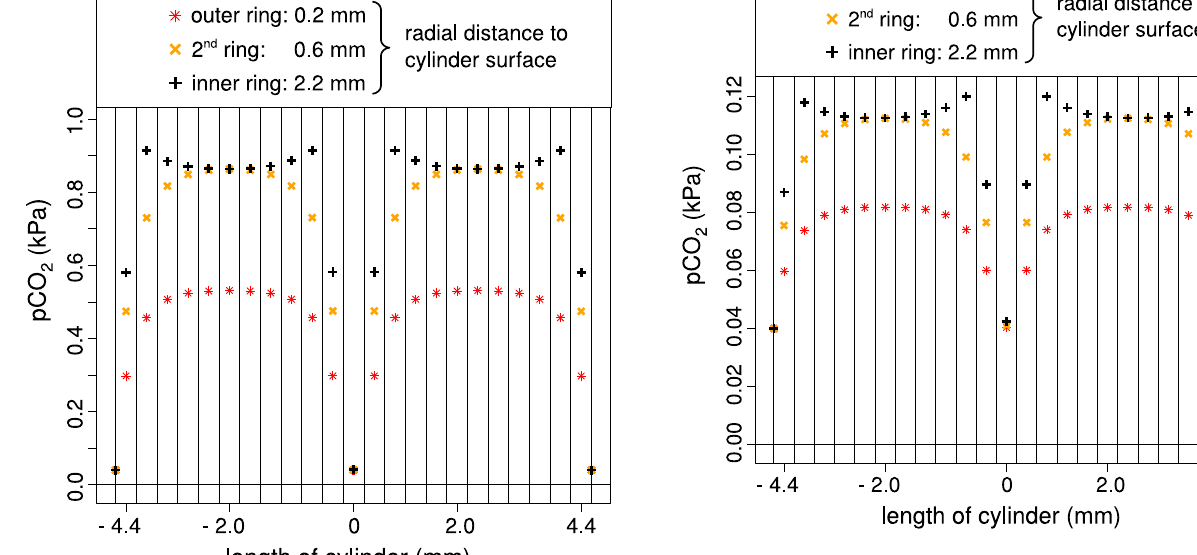
Fig. 7. Modelled CO 2 partial pressures in a calcaric, aerobic soil aggregate (system c) at the soil surface (geometry as in Fig. 3). The pH values are controlled by the carbonic acid. 26